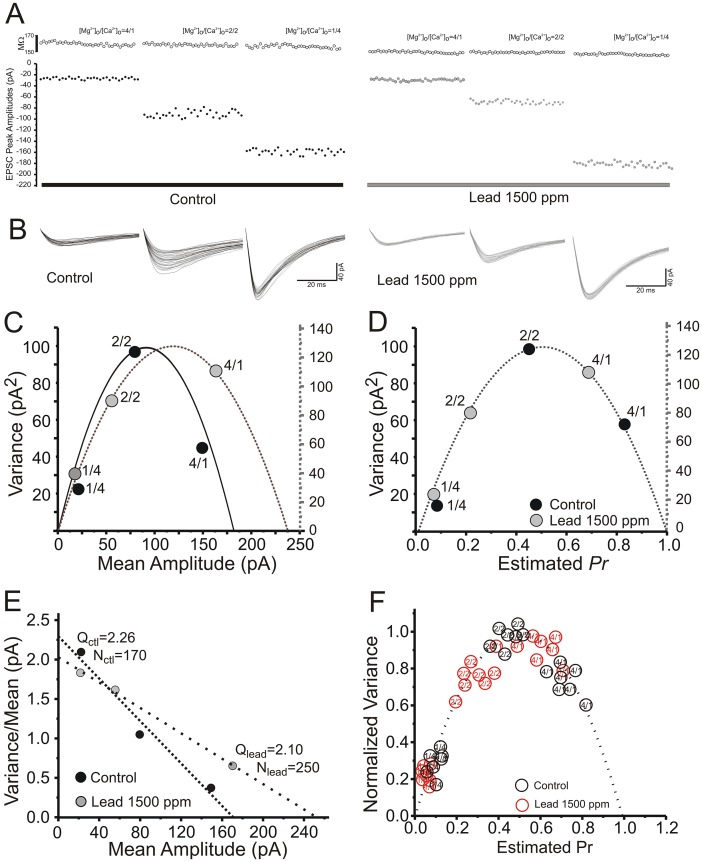
Chronic Pb2+ exposure is associated with reduced presynaptic vesicular release probability at Schaffer collateral-CA1 terminals assessed by variance-mean analysis.(A) CA1 pyramidal neuron input resistance (top, in Meg Ω) and Schaffer collateral-evoked EPSC peak amplitudes (bottom, in pA) recorded at 1, 2 and 4 mM [Ca2+]o, in hippocampal slices from a control (left) and chronic Pb2+-exposed (right) slice. (B) EPSC trace envelopes in CA1 pyramidal neurons in a slice from a Control (left) and a chronic Pb2+-treated (right) rat. (C) Variance-mean relationships determined by altering [Ca2+]o to 1, 2 and 4 mM in CA1 pyramidal neurons in slices from control (black circles; N = 8) and Pb2+-treated (grey circles; N = 7) rats. (D) Data from (C) corrected to estimate P
r, showing mean ± SEM of mean-variance points in slices from control (black circles) and Pb2+-treated (grey circles) rats normalized to the maximal peak amplitude recorded at 4 mM [Ca2+]o. Data from control and Pb2+-exposed slices were both well fit by a single parabola forced to pass through 0,0 with grey circles shifted to the left, consistent with a presynaptic reduction in P
r from chronic Pb2+ exposure. (E) Plot of variance/mean ratio versus mean EPSC amplitude (pA) from a single representative slice, which converts the parabolic relationship between mean and variance to a linear one. The number of release sites (N) was derived by estimating the slope of the linear fit, while the y-intercept denotes the quantal size (Q) of the EPSC. The reduction in slope indicates that chronic Pb2+ exposure was associated with a reduction in presynaptic P
r. (F) Individual variance-mean data points for each control slice (black circles) and each Pb2+-exposed slice (red circles) at each [Ca2+]o.